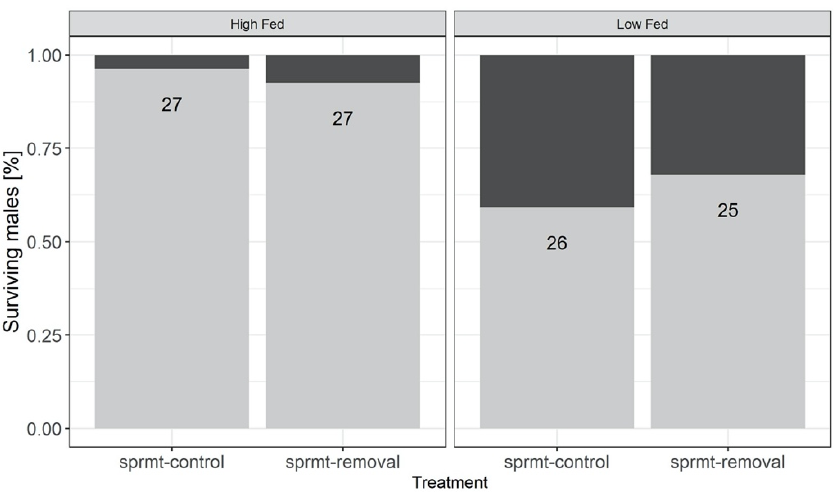
Figure 4. Proportion of males surviving the spermatophore removal treatment exposed to high and low feeding treatments (high-fed and low-fed), with and without experimental spermatophore removal (respectively, sprmt-control and sprmt-removal). Numbers inside bars are total sample sizes. (HR = 9.77, df = 1, p < 0.0001), but did not differ between males with and without sper-